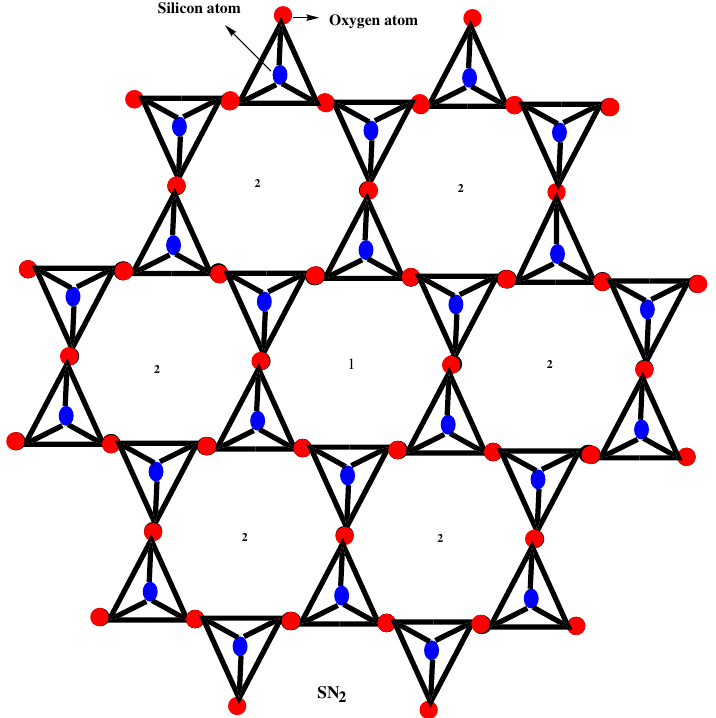
Figure 1. Silicate network of dimension